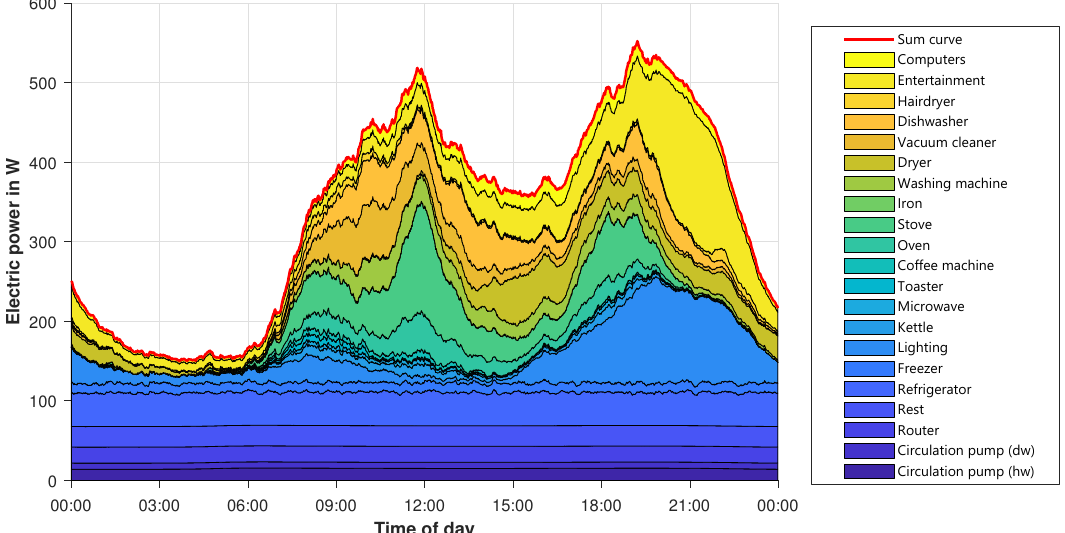
Figure 11. Layered load profiles of devices for